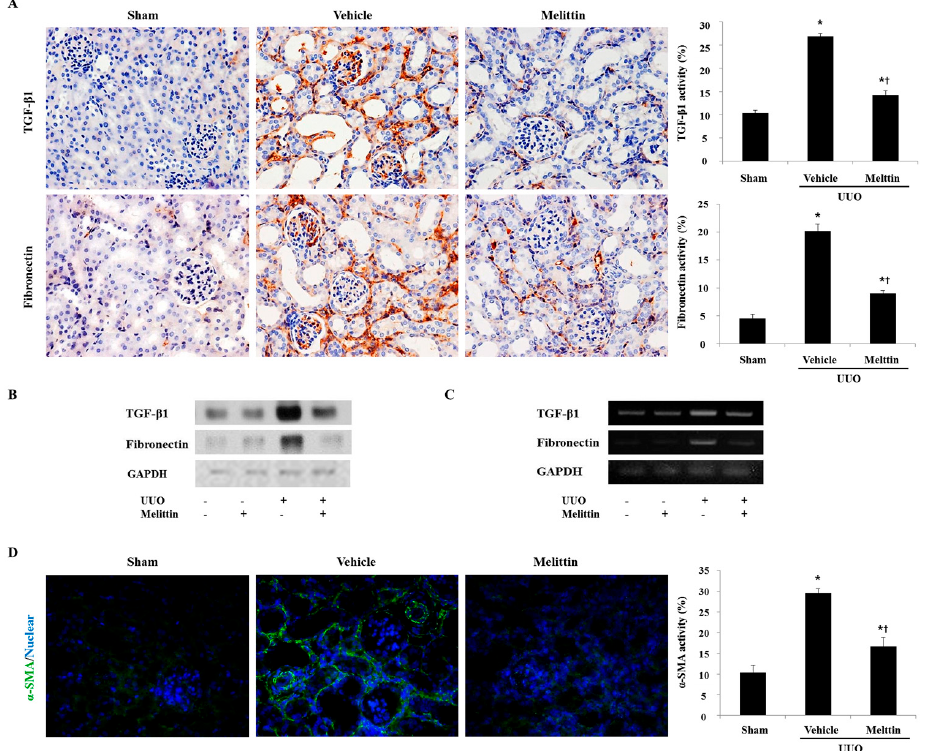
Figure 3. Melittin inhibits the expression of the fibrotic gene in obstructed kidneys. ( A ) Immunohistochemical staining shows that melittin inhibits the expression of transforming growth factor- β 1 (TGF- β 1) and fibronectin in the kidneys after UUO surgery. ( B , C ) Western blot analysis and RT-PCR results shows that melittin suppresses the protein and mRNA expression of TGF- β 1 and fibronectin in UUO kidneys. GAPDH levels were analyzed as an internal control. − : not treated, +: treated. ( D ) Immunofluorescence staining shows that melittin treatment reduces α -smooth muscle actin ( α -SMA)-positive cells in the kidneys at seven days after UUO surgery. The visible green color indicates α -SMA. These are representative images from each study group. Magnification: 400 × . The results are expressed as means ± SE of three independent determinations. * p < 0.05 vs. Sham group. † p < 0.05 vs. Vehicle group.